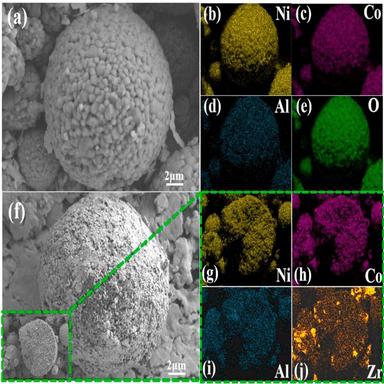
SEM images of (a) NCAL; (b–e) elemental mapping of NCAL electrode; (f) 1 wt % LZO@NCAL anode after test (The inset is the cross-section image of 1 wt % LZO@NCAL spheres); (g–j) elemental mapping of 1 wt % LZO@NCAL electrode.